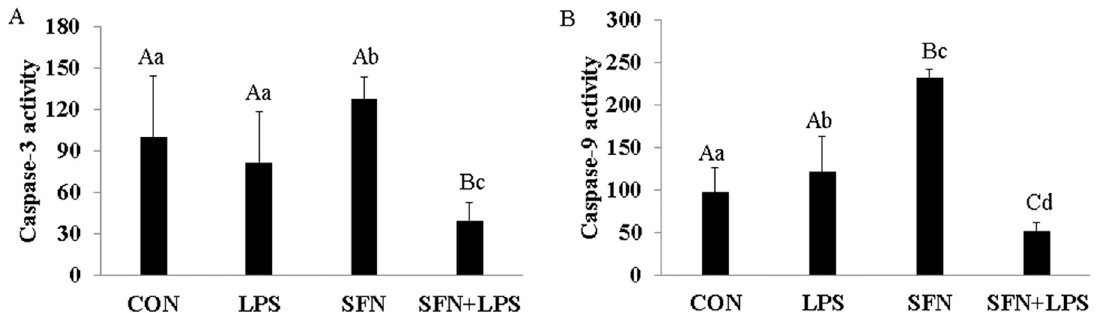
Figure 4. SFN induced caspase-3 and caspase-9 activity and SFN pre-treatment inhibited cell apoptosis. Seven-day-cultured moDCs were used for this experiment. Relative cell apoptotic activity was determined using a Colorimetric Assay Kit. To confirm the induction of caspase-3 and caspase-9 in moDCs, cells were stimulated with LPS for 24 h with or without SFN pre-treatment. Equal amounts of cell lysate were subjected to caspase-3 ( A ) and caspase-9 ( B ) assays. The results were combined from three independent experiments, and each experiment was performed in triplicate. The data are represented as the mean ± standard deviations (SD). Values with different letters denote a significant expression difference among different treated and untreated cells within different groups (small letters: p < 0.05; capital letters: p < 0.01).